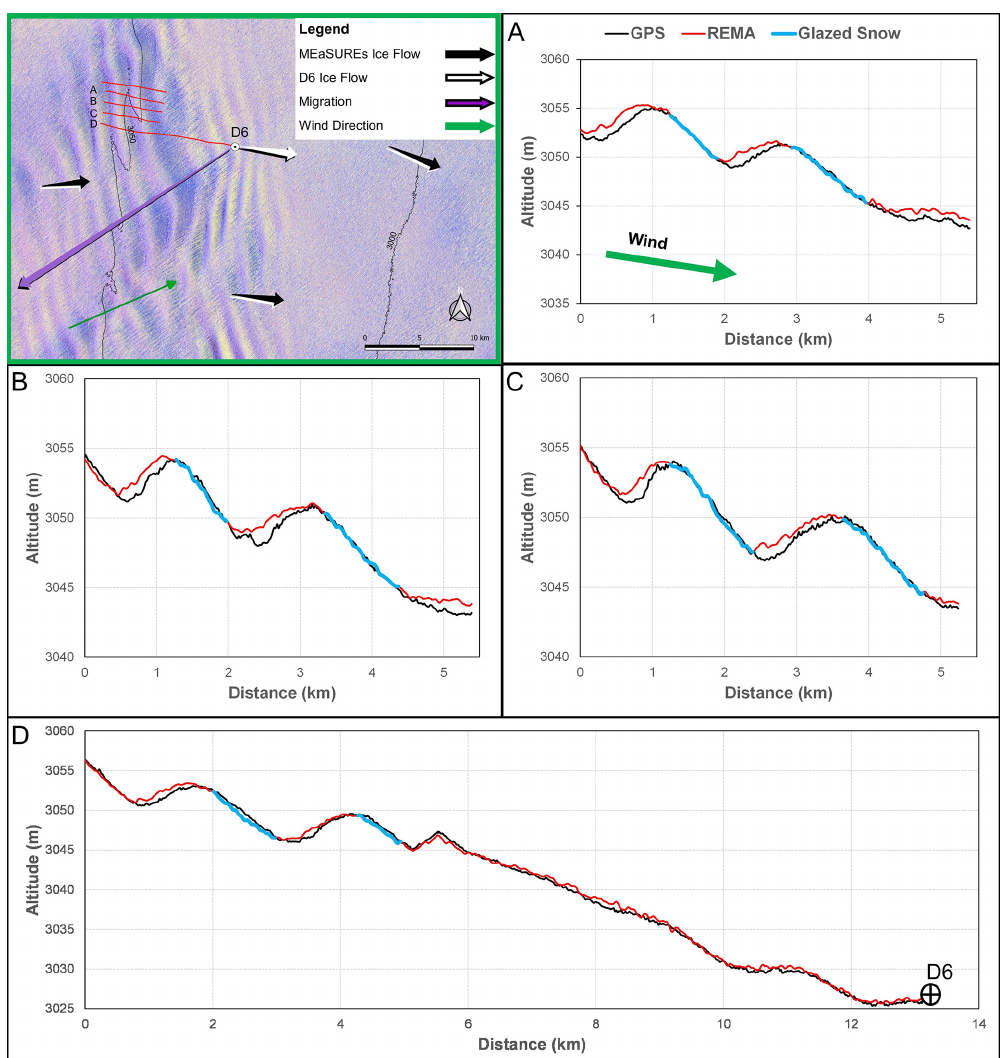
Figure 4. Location of the GPS transects (red) at the It-ITASE site with a false-colour Landsat 8 OLI image in the background (18 De- cember 2014). Universal Transverse Mercator (UTM) projection. Topographic section of four transects ( A , B , C , D ), with the black lines representing elevation from in situ GPS observations (1999), red lines from the REMA DEM (2014) and blue lines from glazed snow detected on the Landsat image from 18 December